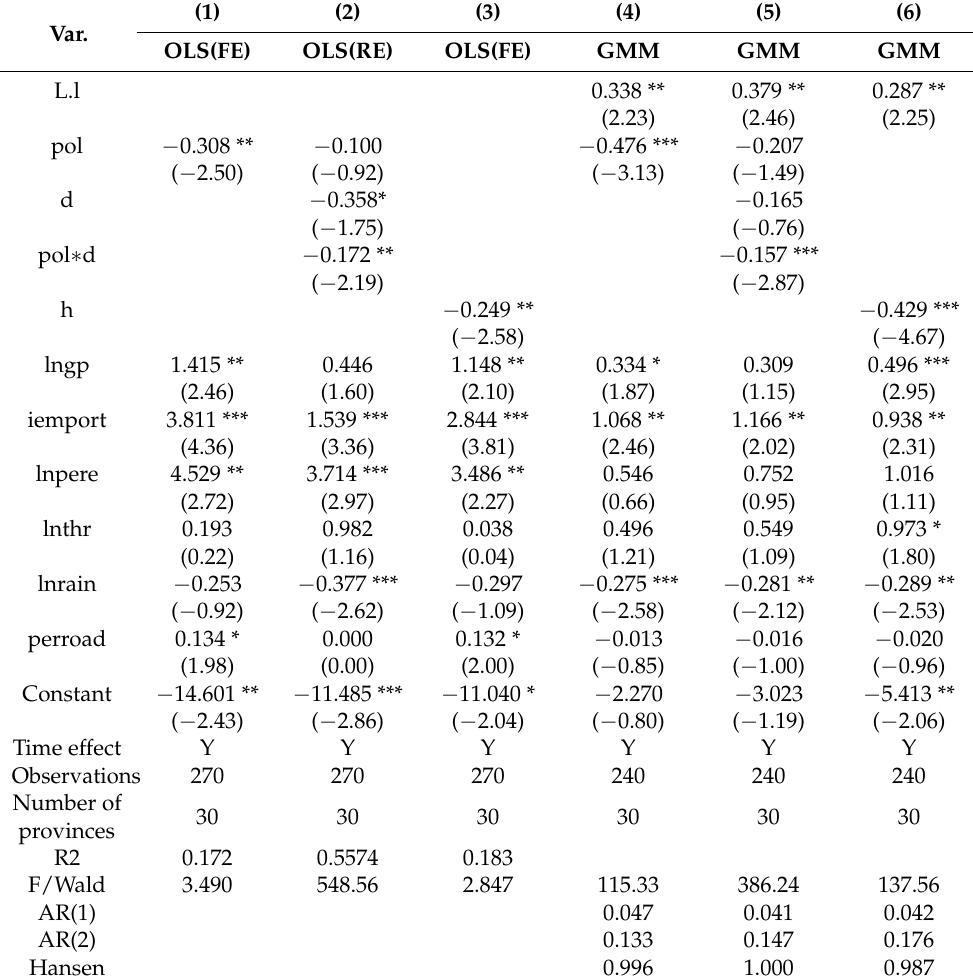
Table 2. The baseline main results of OLS and GMM models.